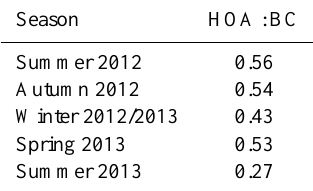
Table 3. Ratios of HOA to eBC for all